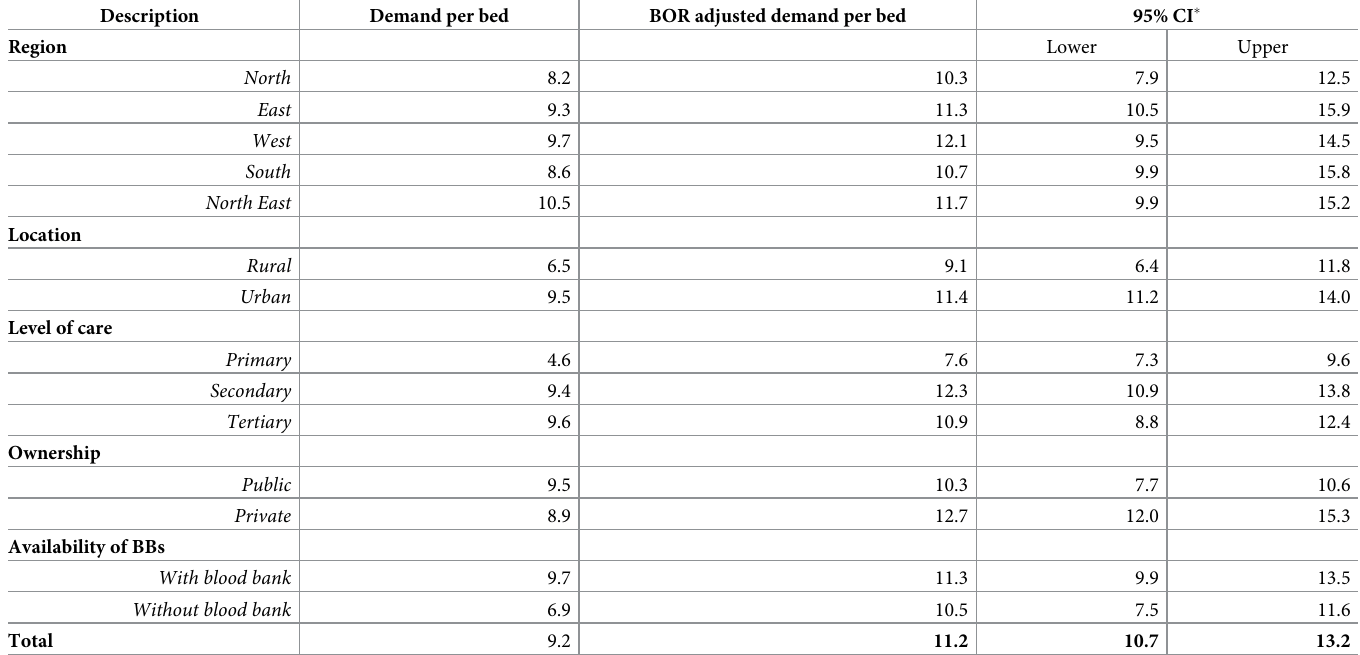
Table 3. BOR adjusted demand per bed in whole blood